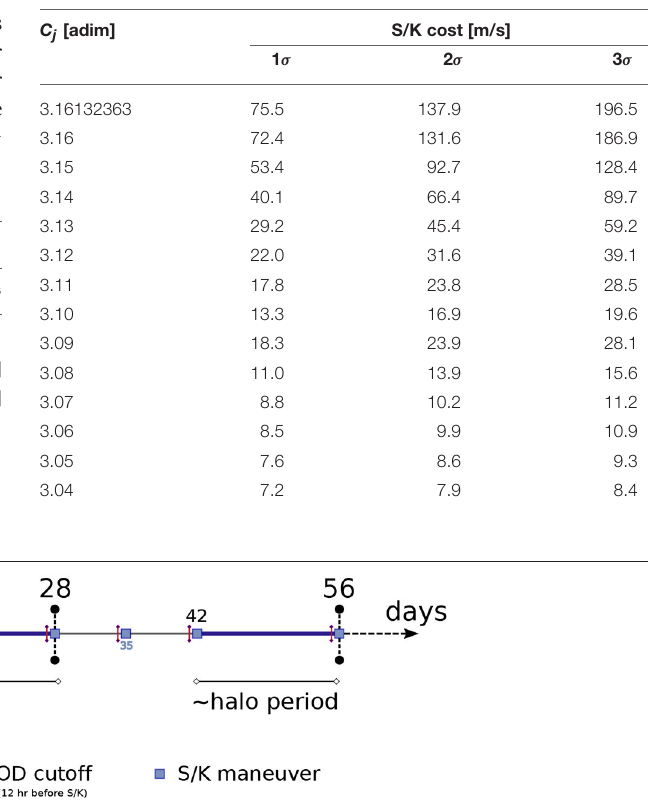
TABLE 11 | Confidence for the 1-year station-keeping cost.